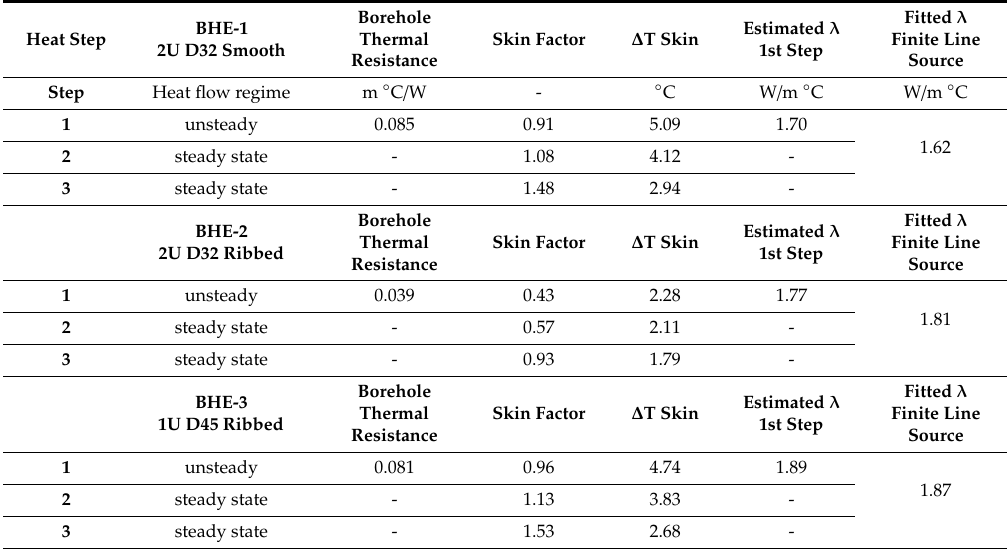
Table 2. Thermal Response Step Test obtained temperature